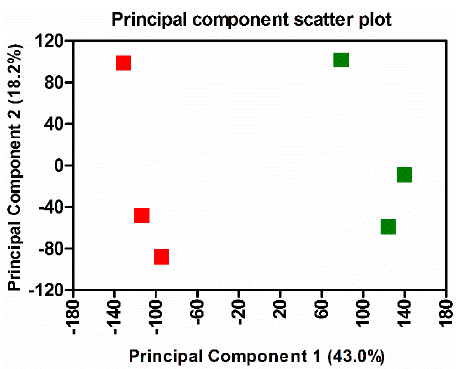
Figure 2. Principal component analysis of gene expression in the lungs of mock-infected controls and R. conorii -infected C3H/HeN mice at three days post-infection. Green: mock-infected control, Red: R. conorii- infected.